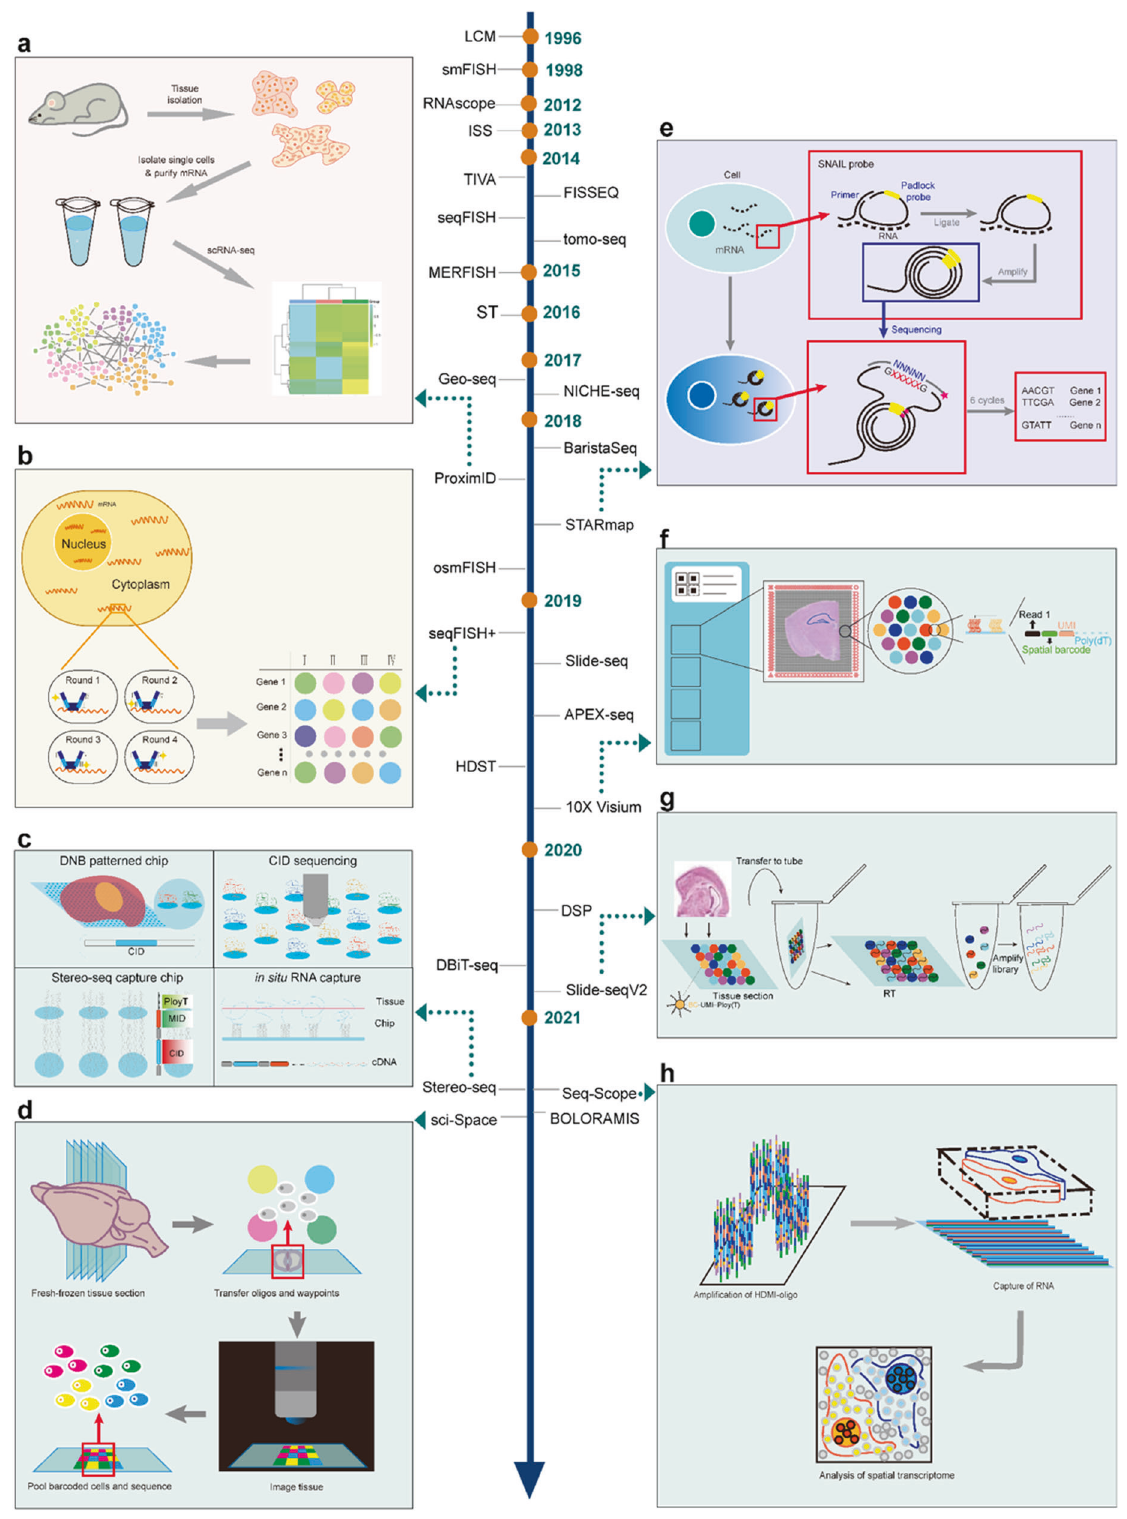
Fig. 1 Development of spatial transcriptomic technologies. Representative technologies were exhibited with detailed schematic diagram, including ProximID, STARmap, seqFISH + , 10× Visium, Slide-seqV2, Stereo-seq, Seq-Scope and sci-Space. The development of ST technologies was shown in the middle part with method names and years. a The principle from cell isolation to interaction networks for ProximID; b The principle of repeated in situ hybridizations for seqFISH + ; c The principle of Stereo-seq; d The principle of sci-Space from fresh-frozen sectioning, oligos and waypoints transferring, and pooled barcoded cell positioning and sequencing, to imaging and reading; e The principle of in situ mRNA preparation, SNAIL probe function, and in situ sequencing for STARmap; f The principle of in situ capturing from tissue grids to spot selection, from sample setting to quality control, and from partial reads to spatial barcodes for 10× Visium; g The principle of Slide- seqV2 from tissue coating to library ampli fi cation; h The principle of Seq-Scope from high-de fi nition map coordinate identi fi er (HDMI)-oligo ampli fi cation to RNA capture from frozen section to achieve spatial transcriptome analysis at the single cell levels Signal Transduction and Targeted Therapy (2022)